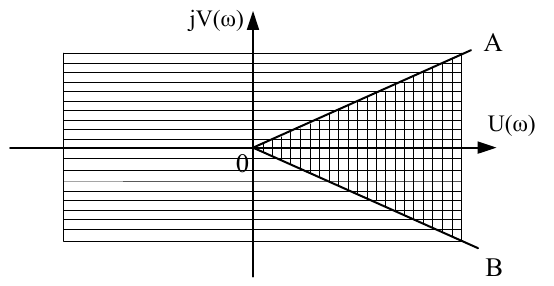
(cid:0) π (cid:1) ; − π , roots are in the sector, the system is unstable; roots 6 6 (cid:4673), roots are in the sector, the system is unstable; roots ; − 𝝅 𝟔 𝟔